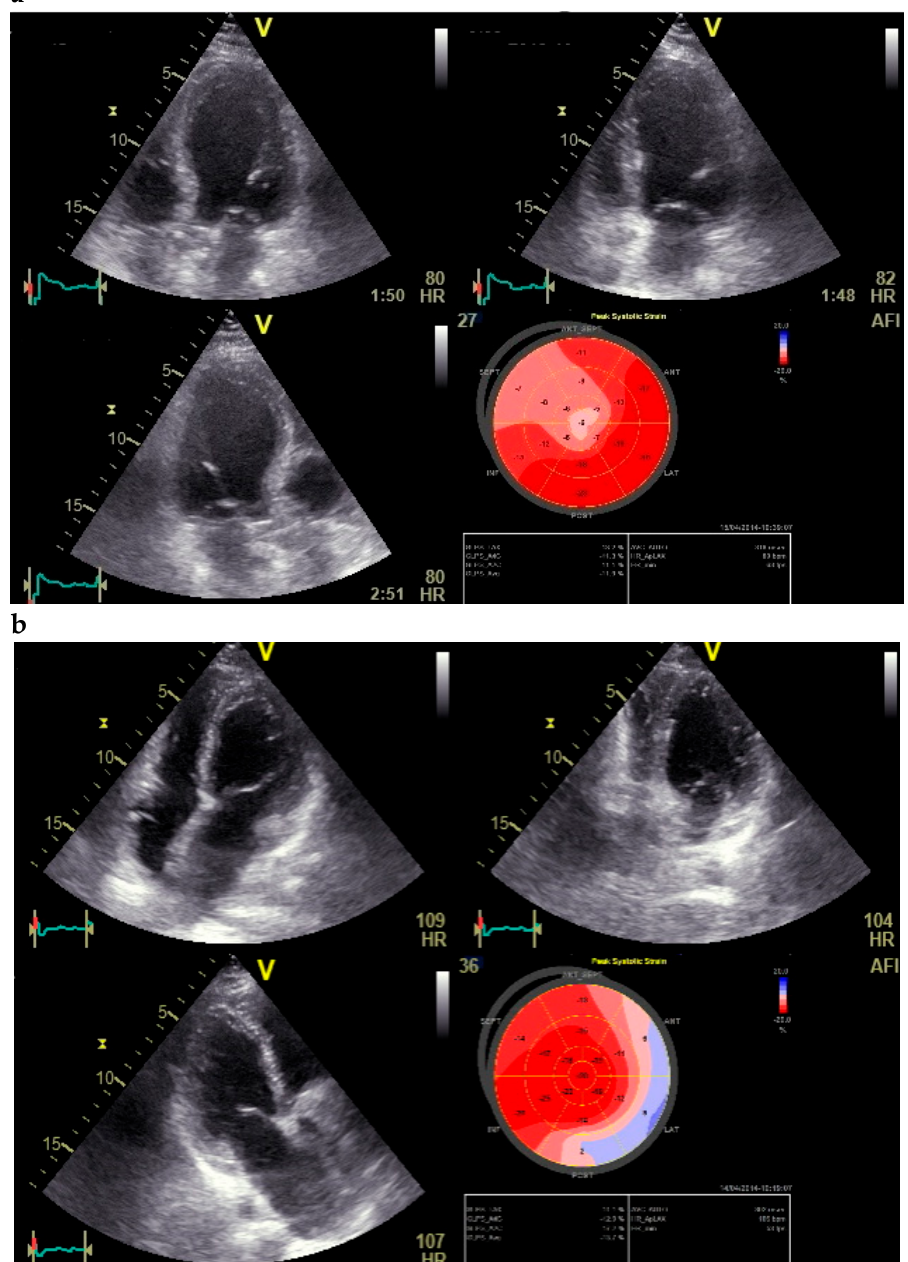
Figure 2. ( a ) Global longitudinal strain (GLS) by speckle tracking at rest showing decreased strain in septal region. ( b ) GLS by speckle tracking under stress (first phase stress at 20 mg/kg/min intravenous infusion of dobutamine) of the same patient showing decreased strain distributed over anterior and anterolateral region (significant left circumflex stenosis was revealed in coronary angiography).